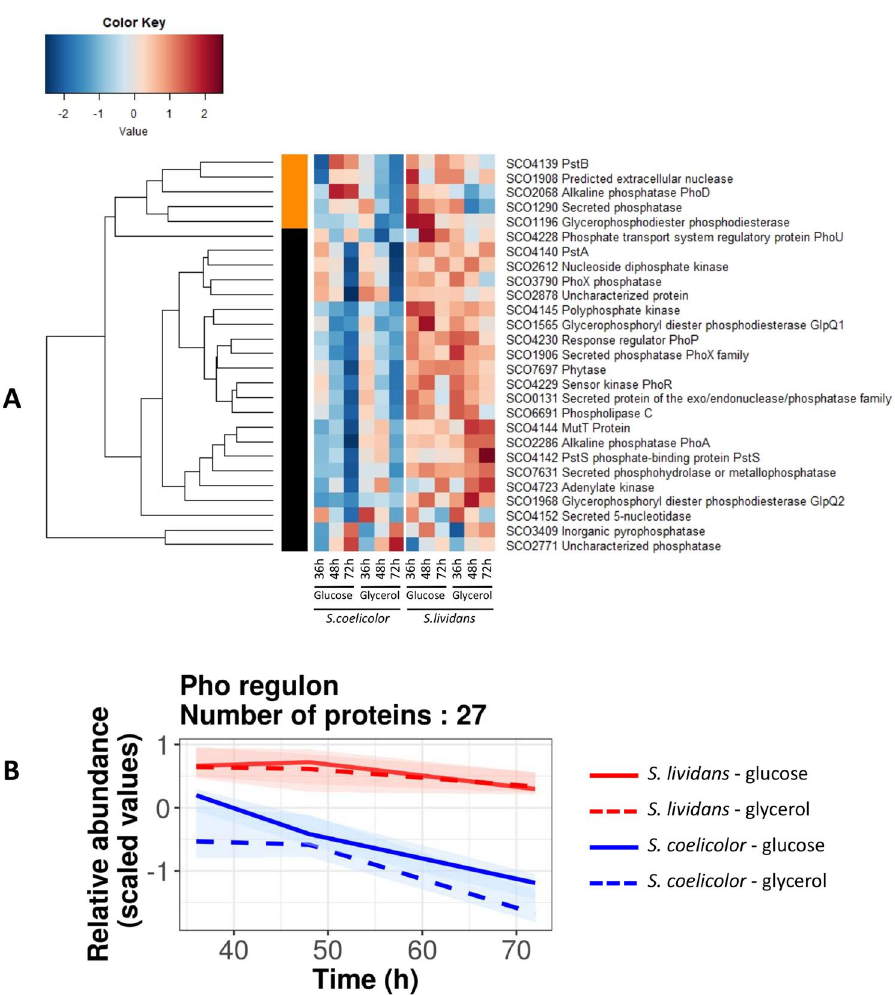
Figure 3. Heatmap representation of proteins of the Pho regulon belonging to phosphate metabolism with significant abundance change (ANOVA, adjusted p value < 0.05) between S. coelicolor (M145) and S. lividans (TK24) with either glucose or glycerol as main carbon source, for 36, 48 and 72 h. The quantification methods are displayed in the vertical bar indicating those proteins quantified by Spectral Counting (orange) or XIC (black) (A) . Corresponding global trends curves (B)